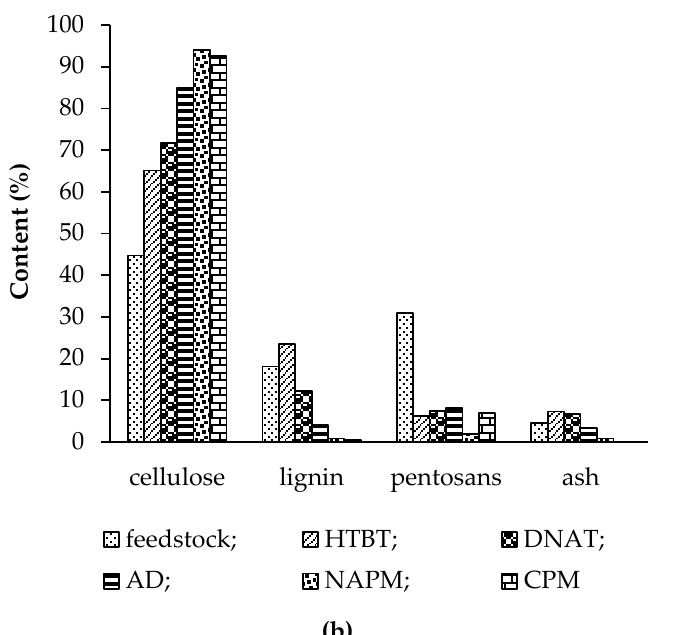
Figure 2. Cellulose, lignin, pentosan, and ash contents of native feedstocks and pretreatment products: ( a ) Miscanthus and ( b ) oat hulls.